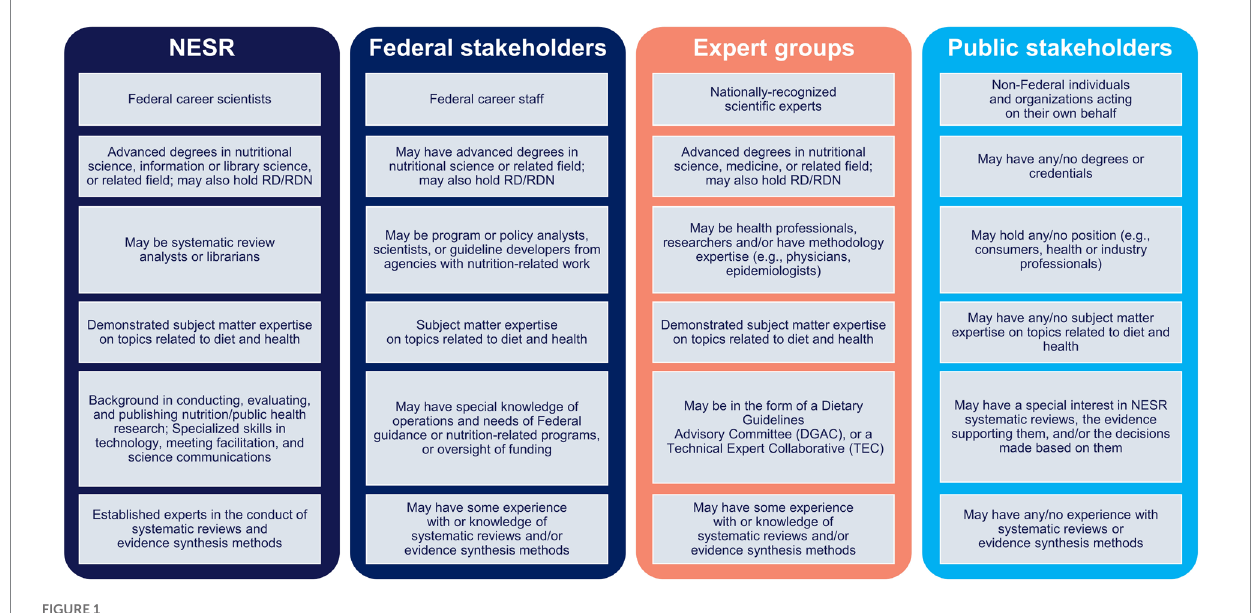
FIGURE 1 NESR and Collaborator positions, credentials, roles, expertise and special